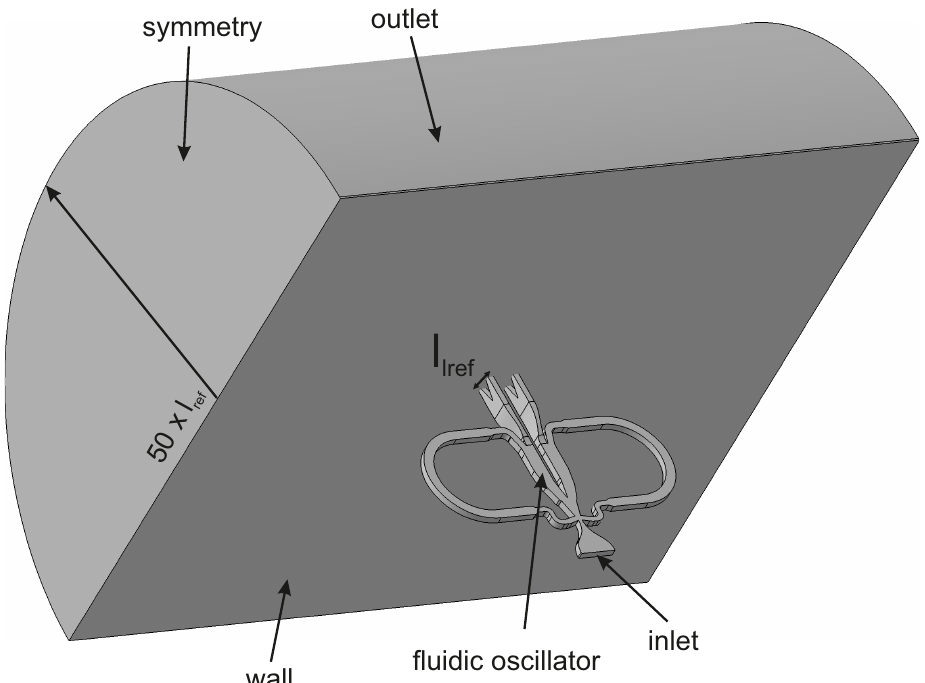
Figure 8. Computational domain and defined boundary patches.